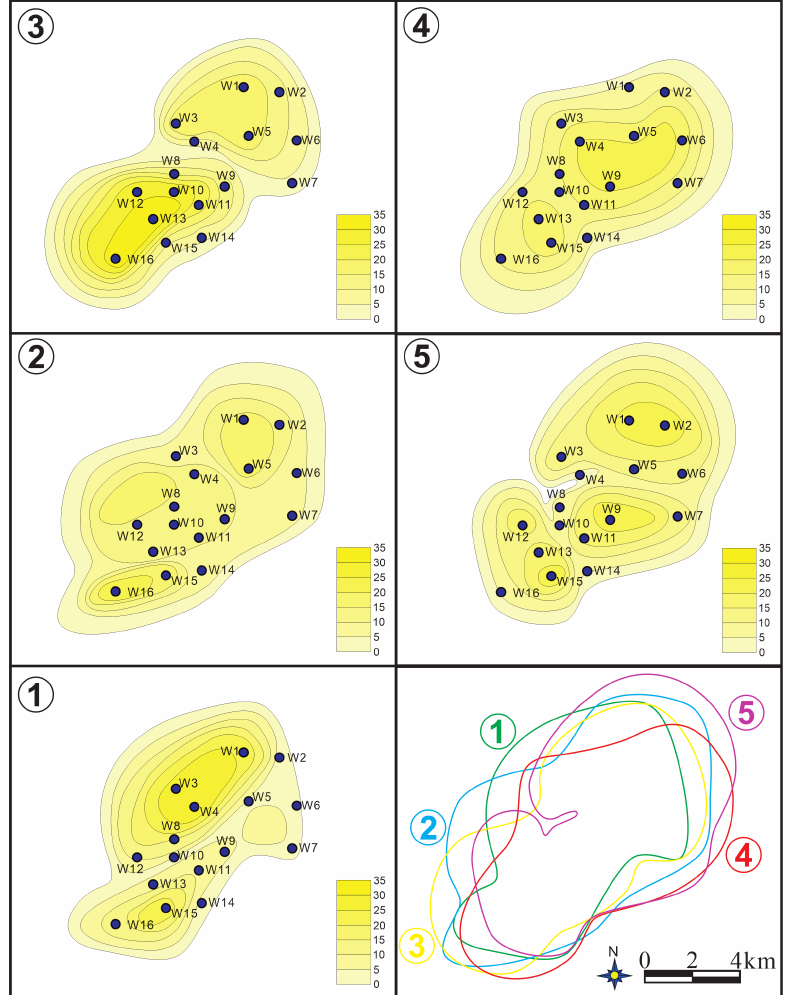
Figure 10. Isopach maps of sandstone thickness and distributions of the five stage sands in the LST of Mbr2 stage in the Weixinan sag. Note that the thickness of sand 3 (cid:13) is greatest, and the distribution area of sand 2 (cid:13) is largest. Horizontal distribution of five stage sands also show a retrograding trend towards the uplift. The numbers 1 (cid:13) – 5 (cid:13) indicate the five stage sands in the LST of Mbr2 stage in the Weixinan sag from the bottom to